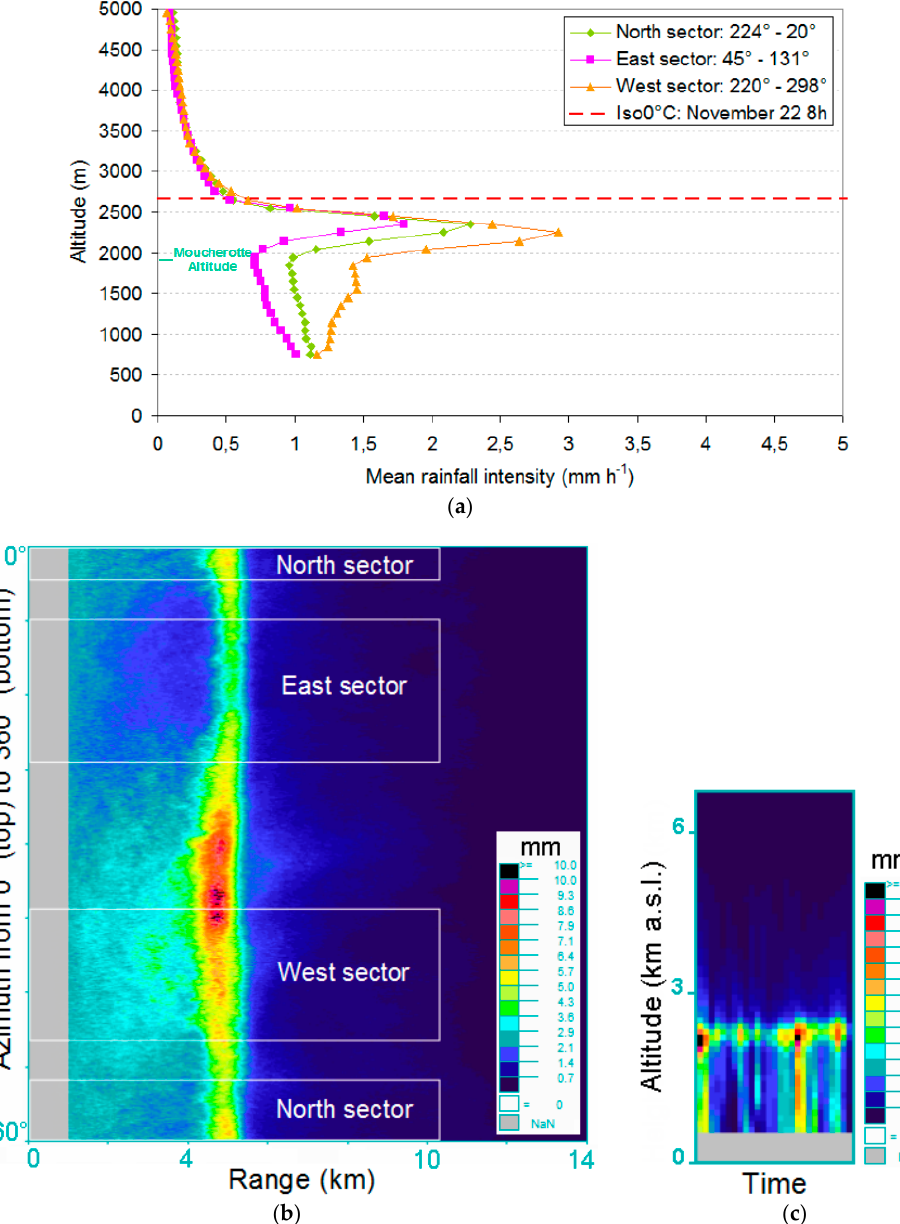
Figure 8. Example of mean apparent vertical profiles impacted by the spatial repartition of the precipitation in the valleys (Nov. 22, 2016, from 7h to 9h20 UTC). ( a ) Mean vertical VP S profiles in three sectors at 25° elevation angle. Reflectivity Z values have been converted in precipitation intensity R, with the relationship Z = 200 R 1.6 . Dashed lines: altitude of 0 °C isotherm from AROME NWP model; ( b ) total radar precipitation accumulation (in mm) by azimuth as a function of range; and ( c ) VP T profiles: temporal evolution of the mean precipitation intensity in mm/h (all sectors combined).